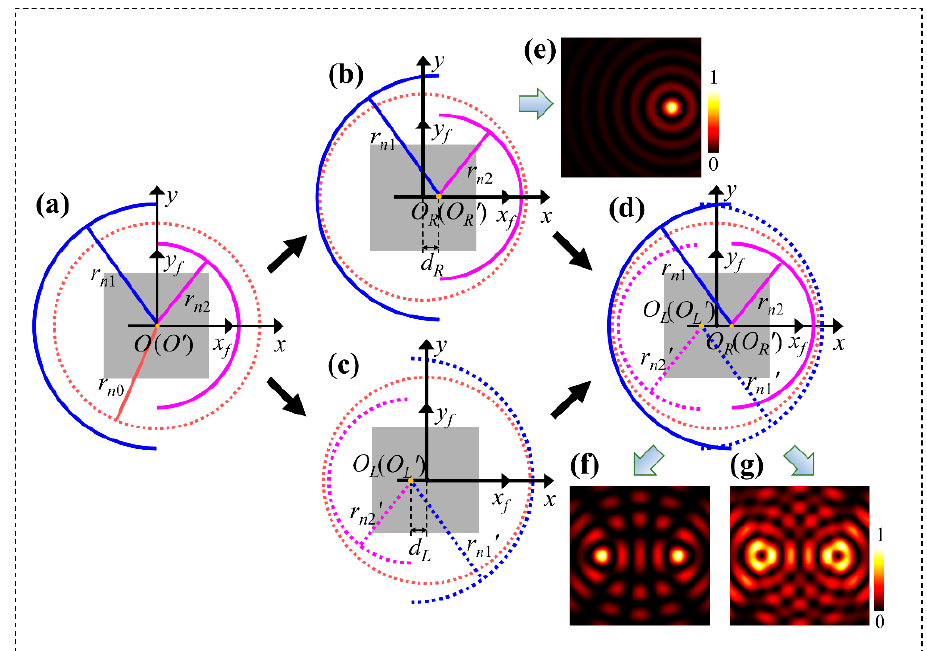
Figure 2. Schematic for the CSRs of Fresnel zone. ( a ) The two semicircular rings of n 2 -th and n 1 -th Fresnel zones with the same center O . ( b ) The right-shifted set of semicircular rings with the center shifted to O R . ( c ) The left-shifted set of semicircular rings with the center shifted to O L . ( d ) CSRs as the superimposition of the sets in ( b , c ). ( e ) The theoretical intensity distribution with the left-shifted spot produced by the structure in ( b ). ( f , g ) The theoretical intensity distribution of the dual spots and vortices produced by the metasurface sample shown in ( d ), respectively.